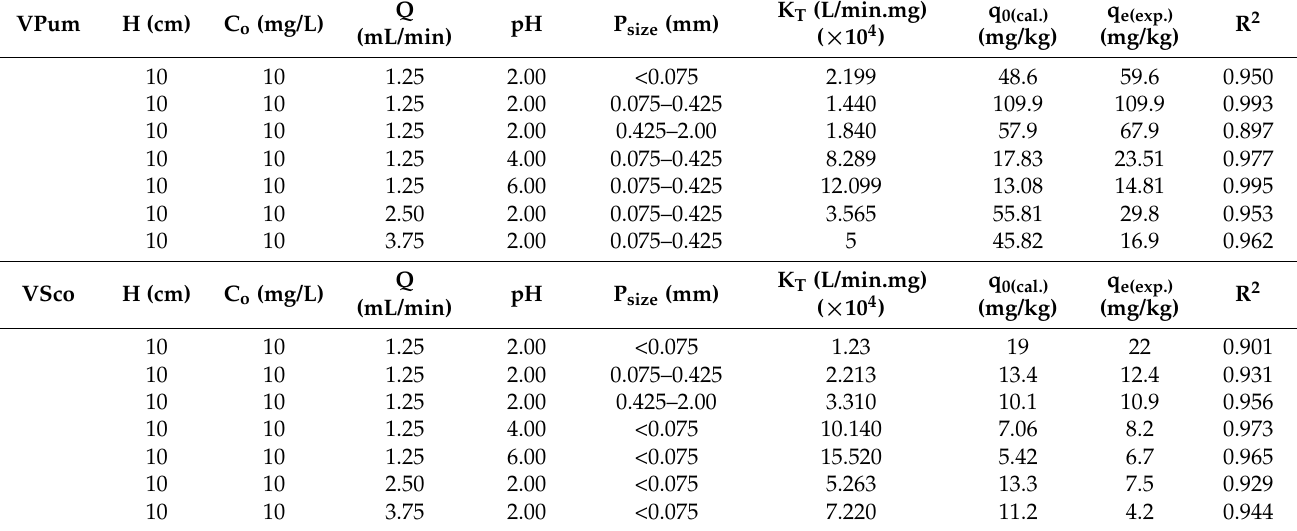
Table 3. Thomas model parameters for fluoride adsorption onto VPum and